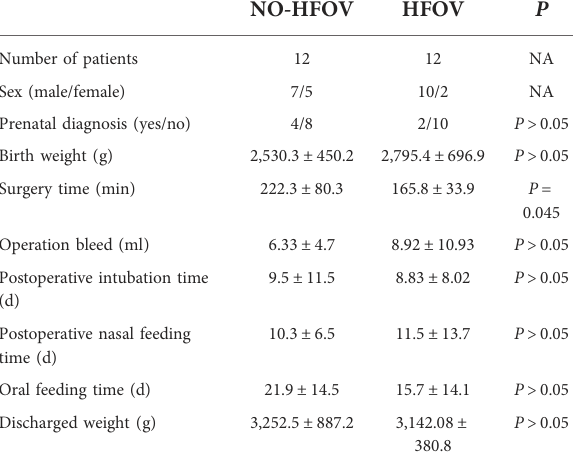
TABLE 4 Comparison with the control group.